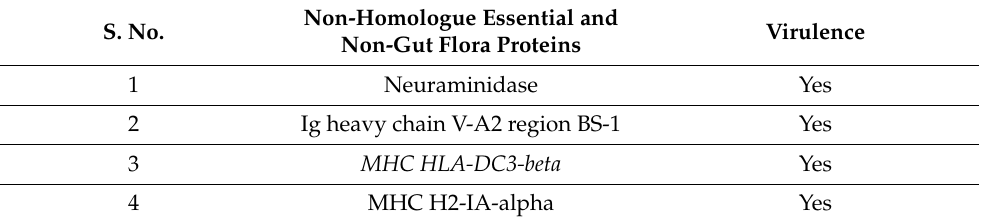
Table 3. Non-homologue essential proteins having less similarities with the gut